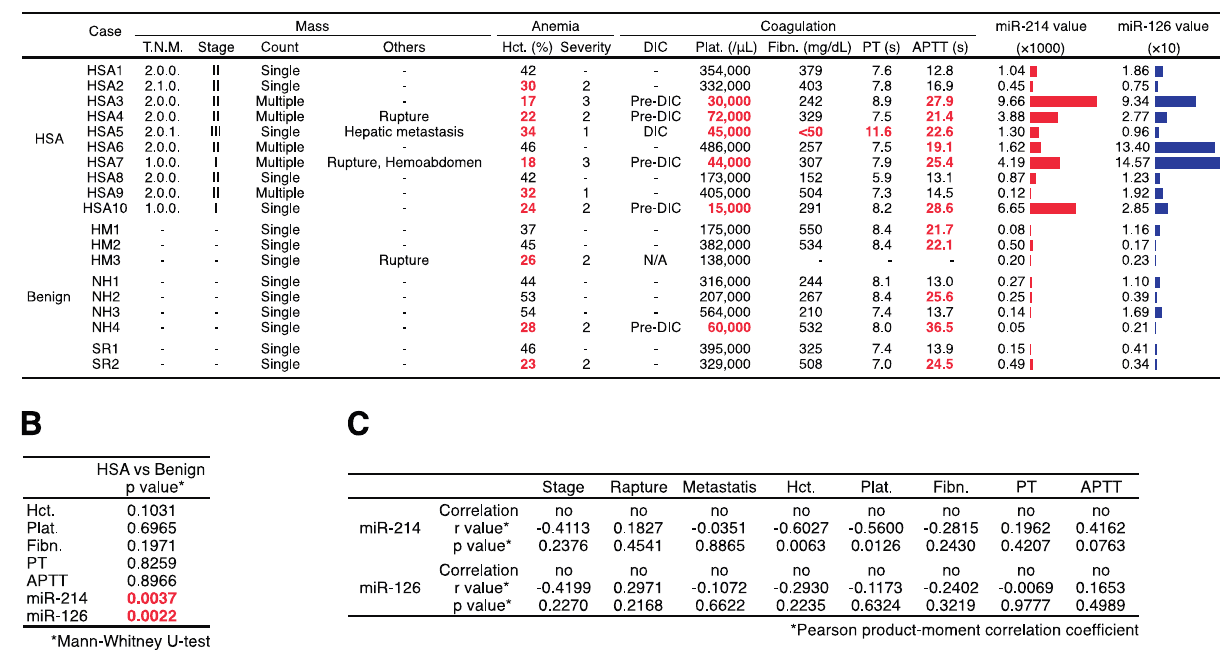
Figure 4. Clinical information about mass, anemia, and coagulopathy. ( A ) The clinical information of each case including the TNM classification (T.N.M.), stage, the count of mass, rupture, metastasis, hematocrit (Hct.), the severity of anemia, the state of disseminated intravascular coagulation (DIC), platelet (Plat.), fibrinogen (Fibn.), prothrombin time (PT), and activated partial thromboplastin time (APTT). The values of Hct. lower than 35% were considered as anemia and marked as red. The severity of anemia was determined based on the following criteria (Severity 1 = 30% to 35% of Hct., Severity 2 = 18% to 29% of Hct., Severity 3 = lower than 18% of Hct.). The values of Plat. lower than 100,000/ μ L were considered as thrombocytopenia and marked as red. The values of Fibn. lower than 150 mg/dL were considered as hypofibrinogenemia and marked as red. The values of PT longer than 10 s. and the values of APTT longer than 19 s. were considered as prolongation and marked as red. The cases were diagnosed as DIC (Pre-DIC) on the presence of together with three (two) of the following anomalies: thrombocytopenia, PT and/or APTT prolongation, and hypofibrinogenemia—considered as pre-DIC when two criteria; ( B ) The p-values regarding the differences of Hct., Plat., Fibn., PT, APTT, miR-214, and miR-126 between HSA and benign groups. There was no significant difference between HSA and benign group in the clinical conditions but in the levels of miR-214 and miR-126 (Mann-Whitney U -test); ( C ) The result of Pearson product-moment correlation coefficient. There was not any correlation between the levels of miRNAs and these clinical